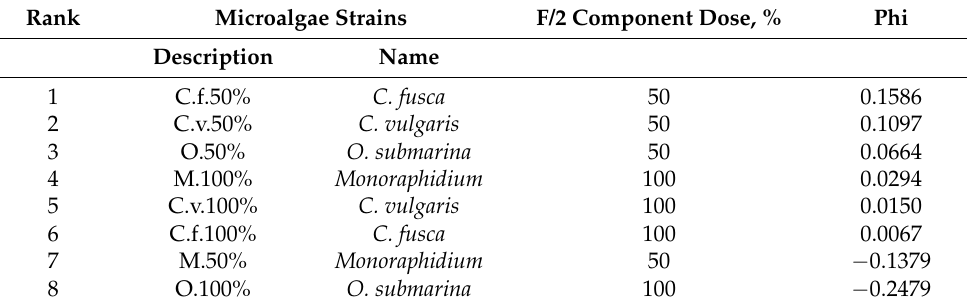
Table 3. Ranking list of microalgae according to their suitability for biodiesel